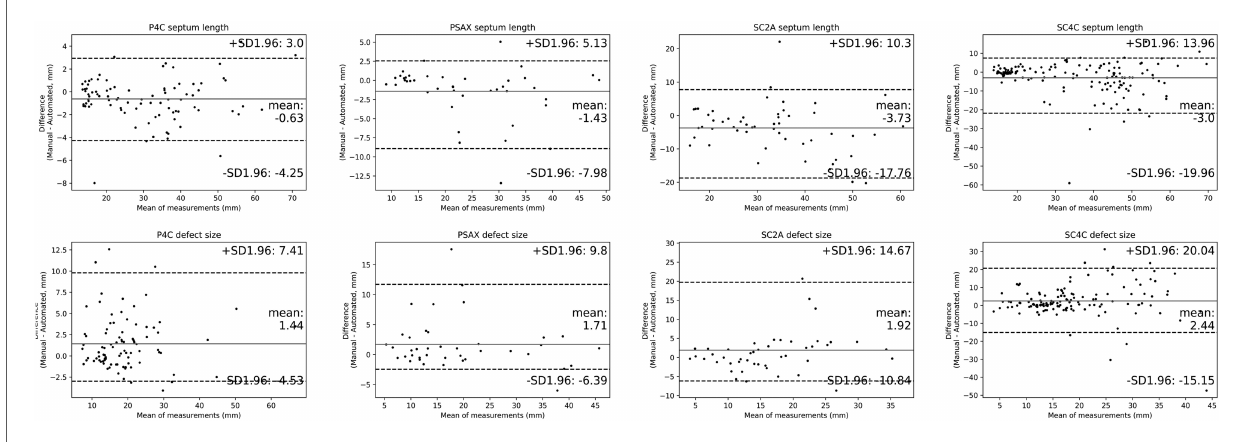
FIGURE 7 Comparisons of quantitative metrics derived from the deep learning (DL) algorithm and physician based on bland and altman analysis. Bland-Altman plots compare automated and manual measurements for septum length and defect size in A4C, PSAX, SC2A and SC4C view. Abbreviations as in Figure 1